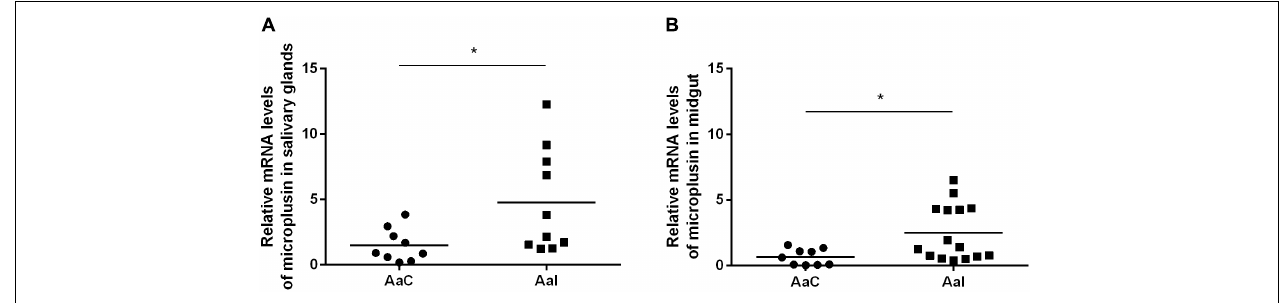
FIGURE 2 | Relative expression of microplusin in salivary glands (A) and midgut (B) of ticks infected (AaI) or not (control; AaC) with R. rickettsii by RT-qPCR ( ∗ p < 0.05; Mann–Whitney test).